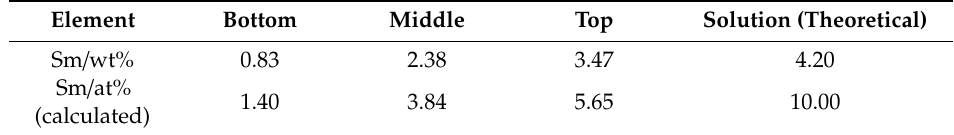
Table 2. The XRF results of the 10 at% Sm:LGN crystal.